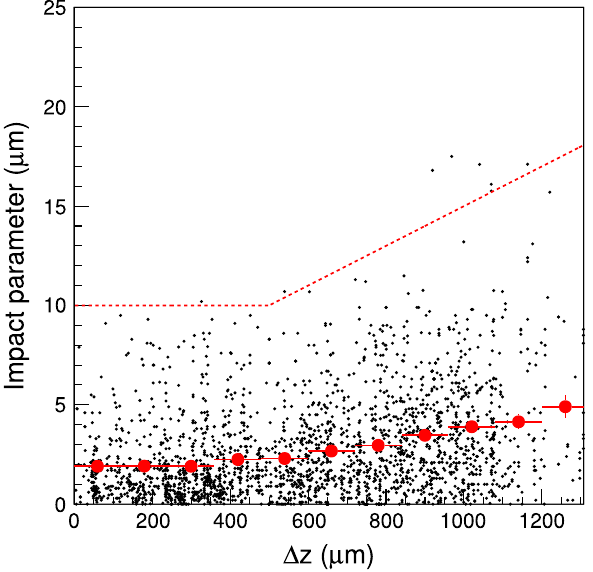
Fig. 2 Primary track impact parameters as a function of the longitu- dinal distance from the neutrino interaction vertex (2008–2009 data). The red bullets show the average value for each bin. The dotted red line represents the lower limit applied to select decay candidates